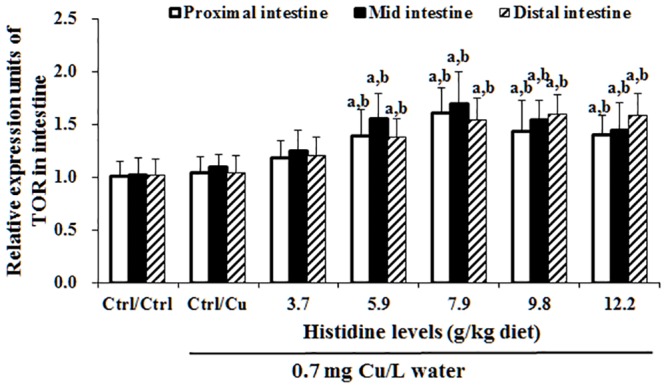
Cu induces an increase in TOR mRNA levels in fish intestine. Protocol and indications are shown in Fig 3.TOR, Target of rapamycin.